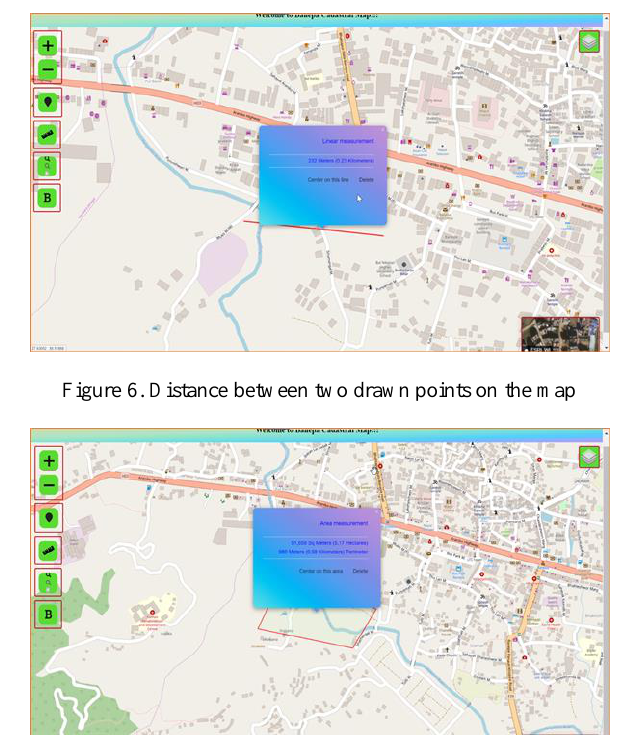
Figure 5. Operation to locate the position of the clicked point